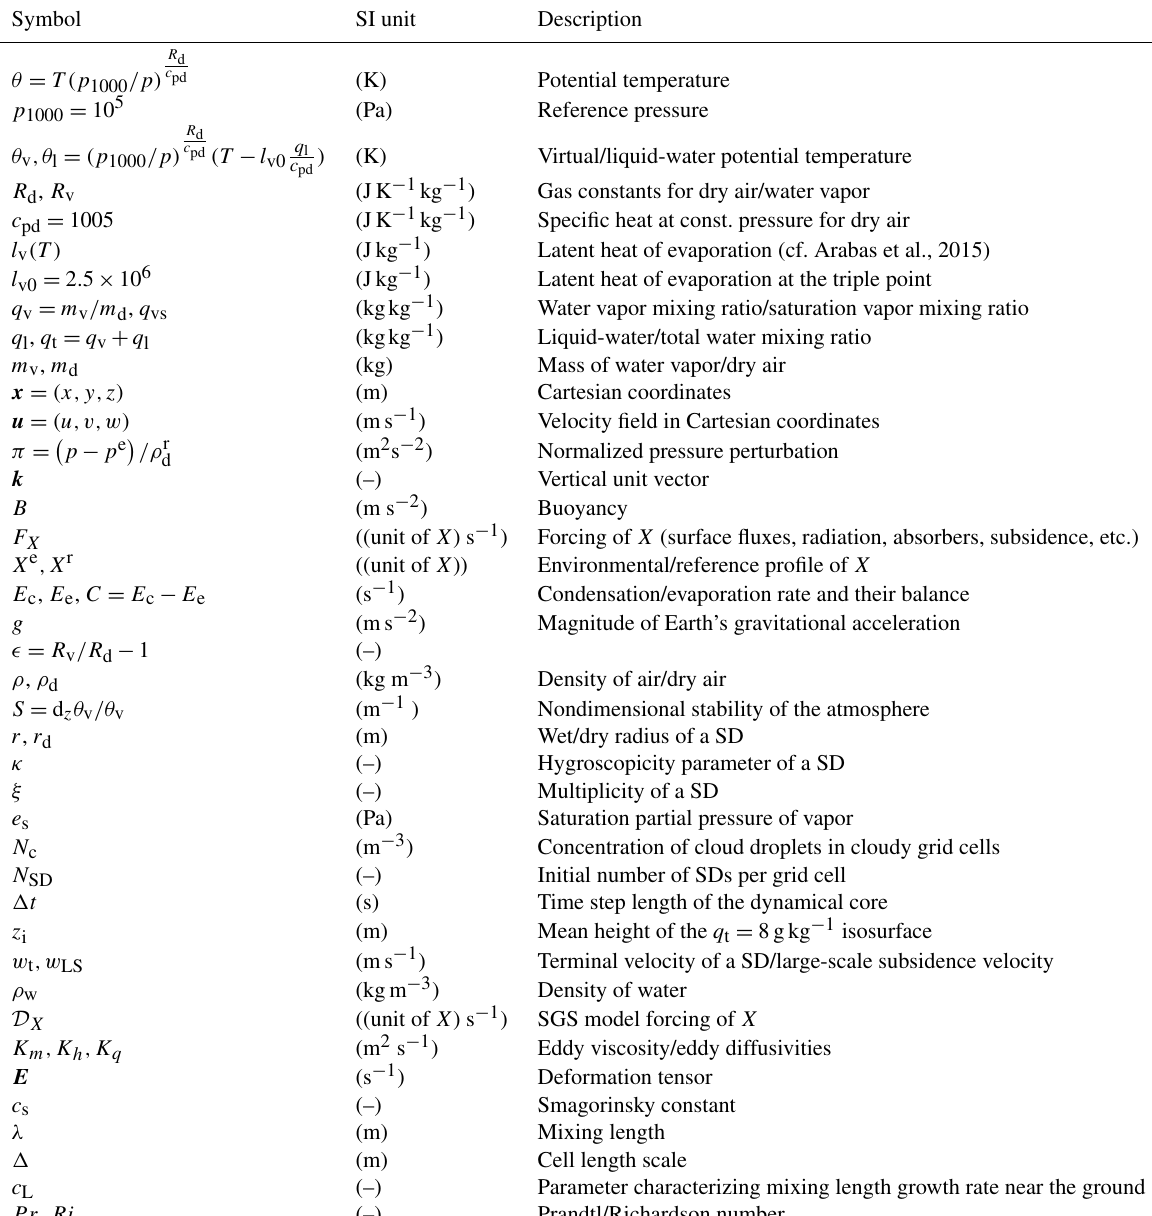
Table A1. List of symbols. As in Ackerman et al. (2009), cloudy cells are those with a concentration of cloud droplets greater than 20cm − 3 . Cloud droplets are liquid particles with a radius in the range of 0.5µm < r < 25µm. The cloud fraction is the ratio of cloudy cells to the total number of cells. Precipitation flux in a cell is calculated as calculated over all SDs in the